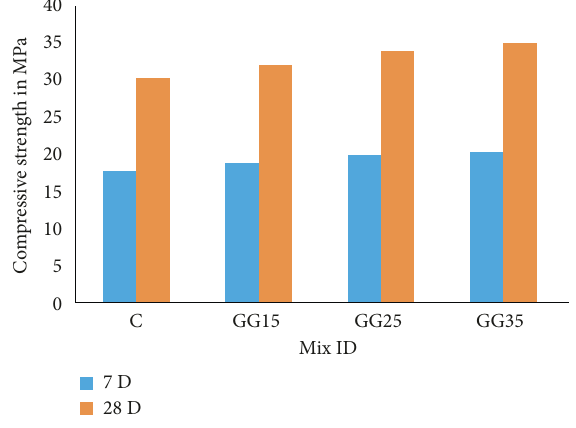
Figure 13: Compressive strength